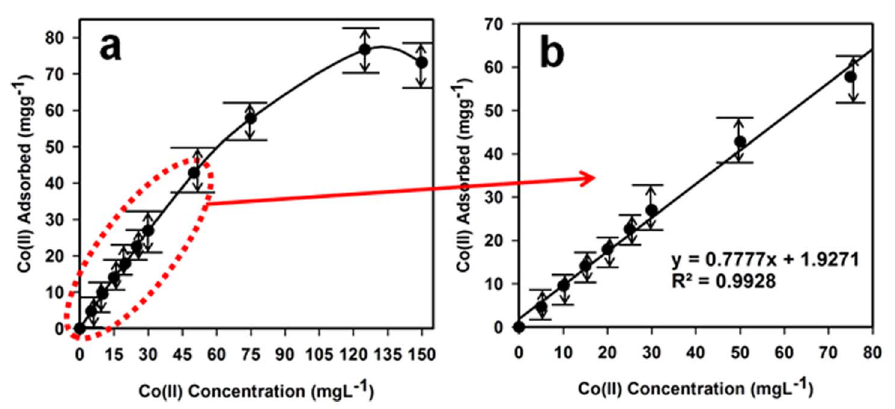
Figure 8. Studied of Adsorption behavior. (a) Adsorption profile and (b) calibration plot of Co(II) on 25.0 mg Ag 2 O 3 -ZnO NCs phase in relation to the concentration at pH 5.0 and 25.0 ˚